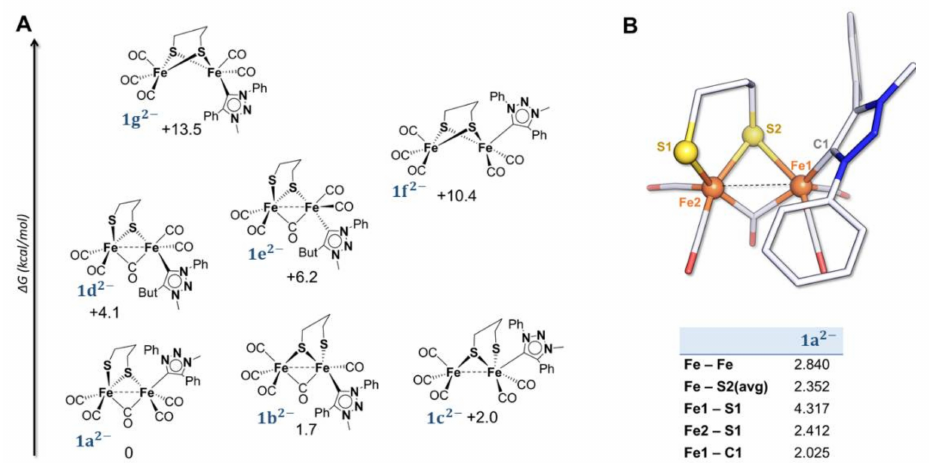
Figure 4. ( A ) thermodynamic speciation of 1 2 − and ( B ) optimized structure of 1a 2 − with relevant geometrical parameters (distances in Å). Atom coloring: Fe = orange, S = yellow, C = grey, N = blue, and O = red. H atoms are omitted for clarity. For simplification, net charges on structures are not